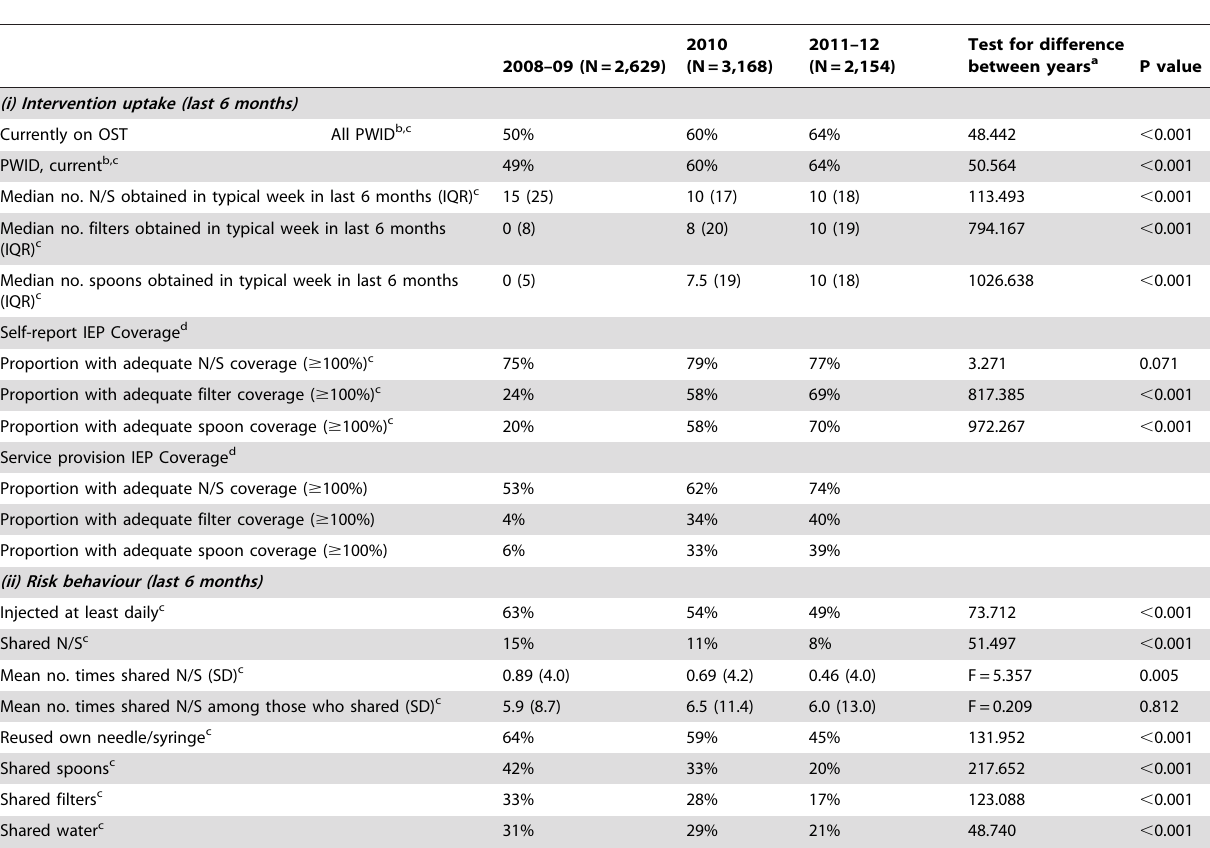
Table 3. Group-level analyses: risk behaviour and harm reduction intervention uptake of study sample, by